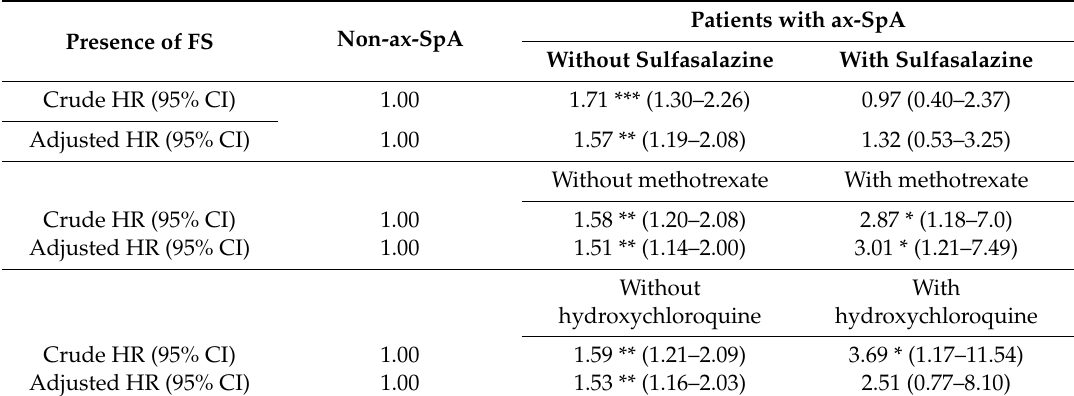
Table 3. Incidence, crude and adjusted hazard ratios, and 95% confidence intervals for adhesive capsulitis during the 7 years of follow-up ( n = 14,295).